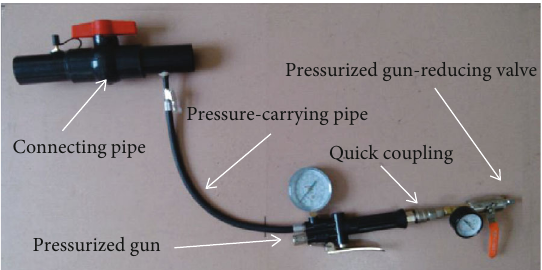
Figure 2: Assembly structure of test